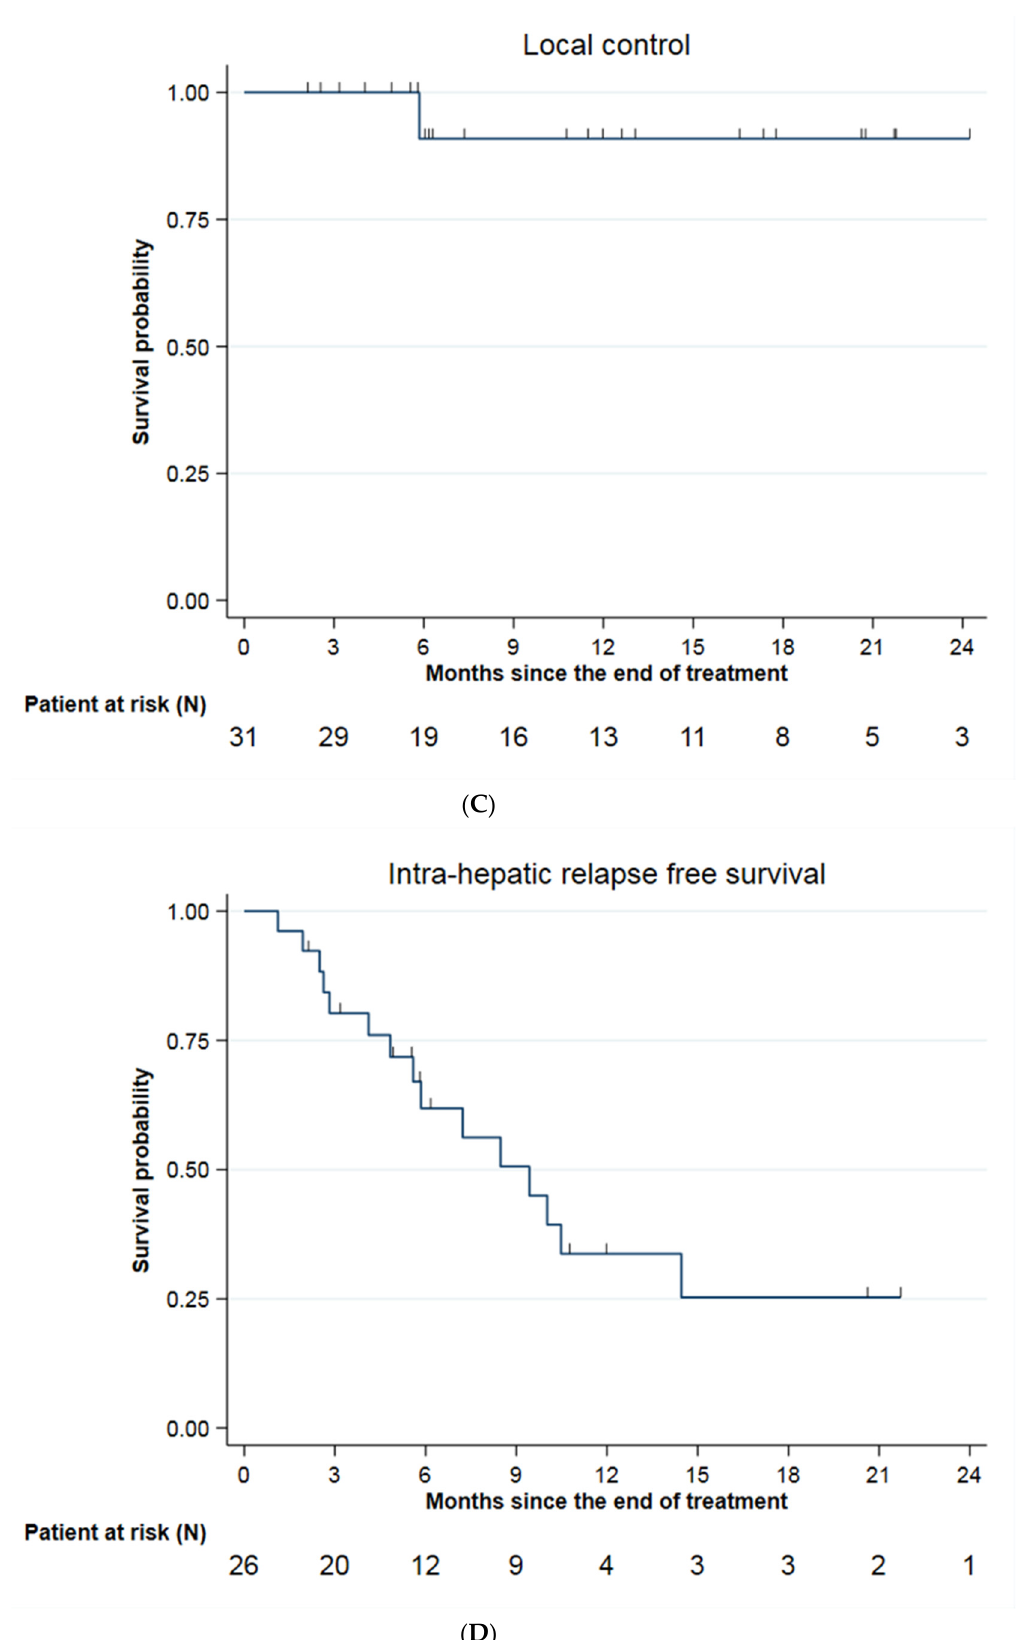
Figure 2. Survival data. ( A ): Overall survival; ( B ): Disease-free survival; ( C ): Local control; ( D ): Intra- hepatic relapse-free